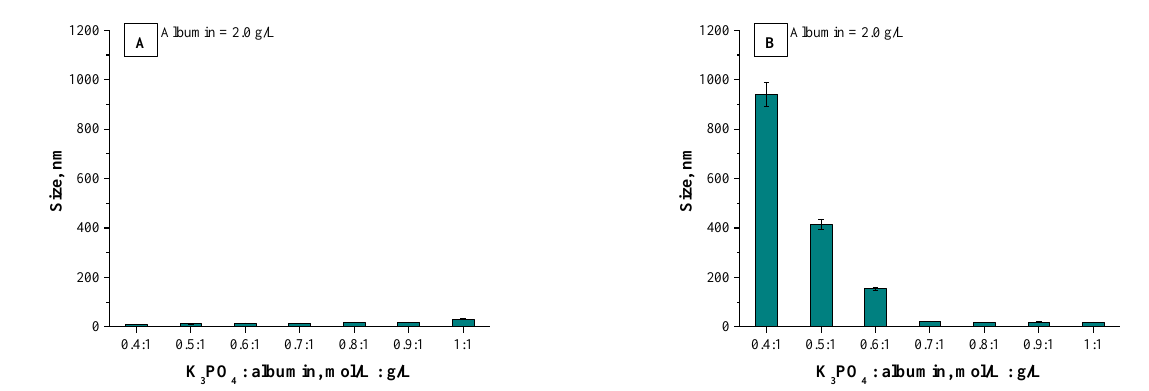
Figure 6. Results of DLS analysis of albumin particles obtained using various albumin concentrations via a syringe system ( A ) and using a burette ( B ) ( n = 3, n —Number of repetitions).